Question: Name the type of graph shown.
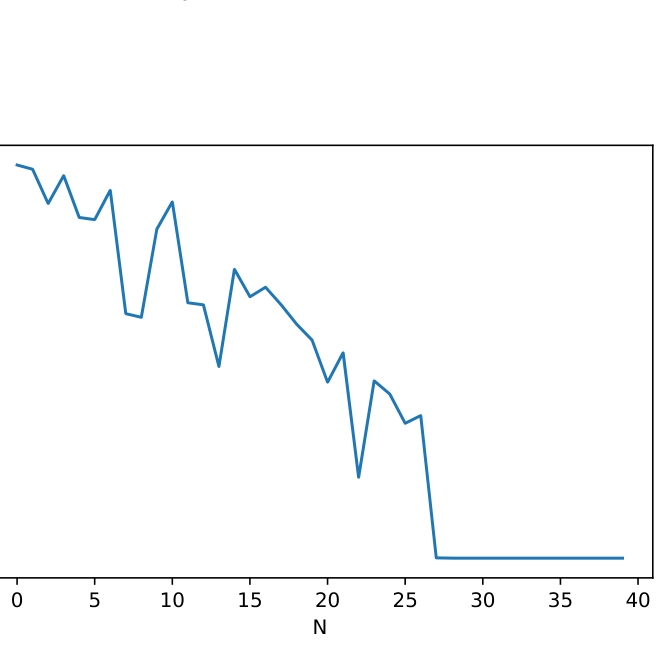
Answer: line